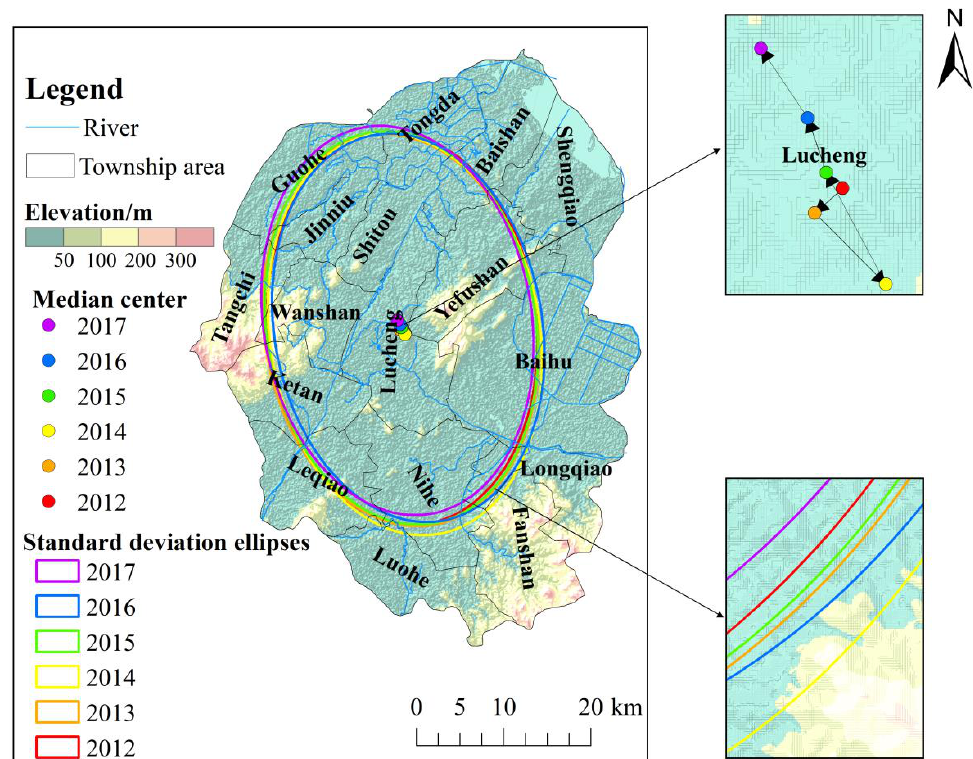
Figure 6. The standard deviational ellipse and gravity center transfer path of the incidence of digestive tract cancer in residents of Lujiang County from 2012 to 2017.